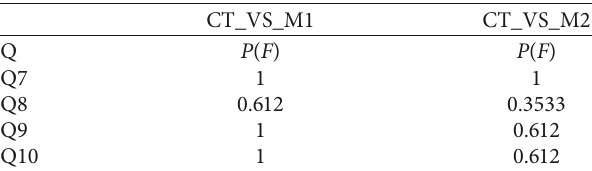
Table 5: P ( F ) values of Fisher’s exact test. Values are significant at α � 0.05 level.